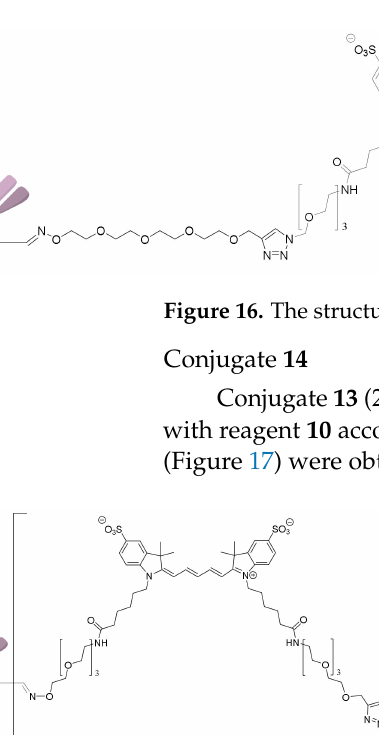
Figure 15. The structure of conjugate 18 . Conjugate 11 Conjugate 9 (77 µ g, 0.51 nmol) was modified with reagent 10 according to general procedure B; 22 µ g (0.15 nmol, 29%) of conjugate 11 (Figure 16) were obtained, the degree of labeling measured by sCy3 absorbance was 1.0.